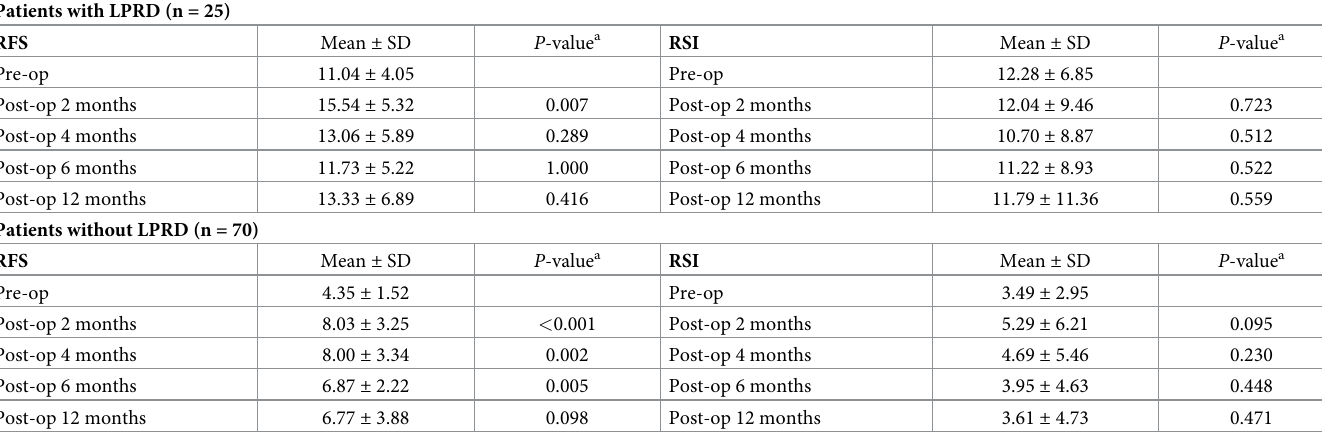
Table 3. The Reflux Finding Score (RFS) and Reflux Symptom Index (RSI) before and after thyroidectomy according to the presence of Laryngopharyngeal Reflux Disease (LPRD) preoperatively. Patients with LPRD (n =